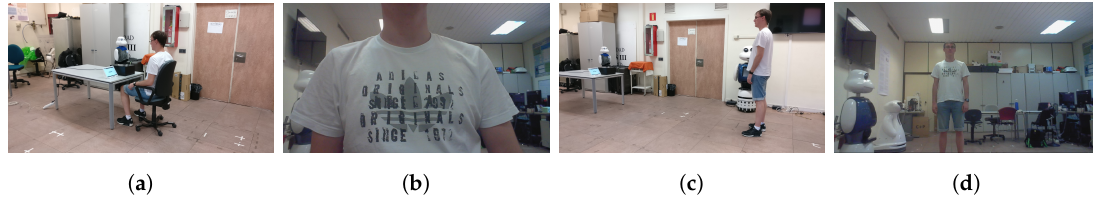
Figure 2. User standing in front of the robot. At a short range, the face detection cannot be applied since the head of the user is not visible in the image. At a medium and long range, the face can be detected but the depth stream cannot be used due to its limited range, 1.5 m. ( a ) User seated in front of the robot at 50 cm; ( b ) Robot’s view with the user seated in front of the robot at 50 cm; ( c ) User standing in front of the robot at 300 cm; ( d ) Robot’s view with the user standing in front of the robot at 300